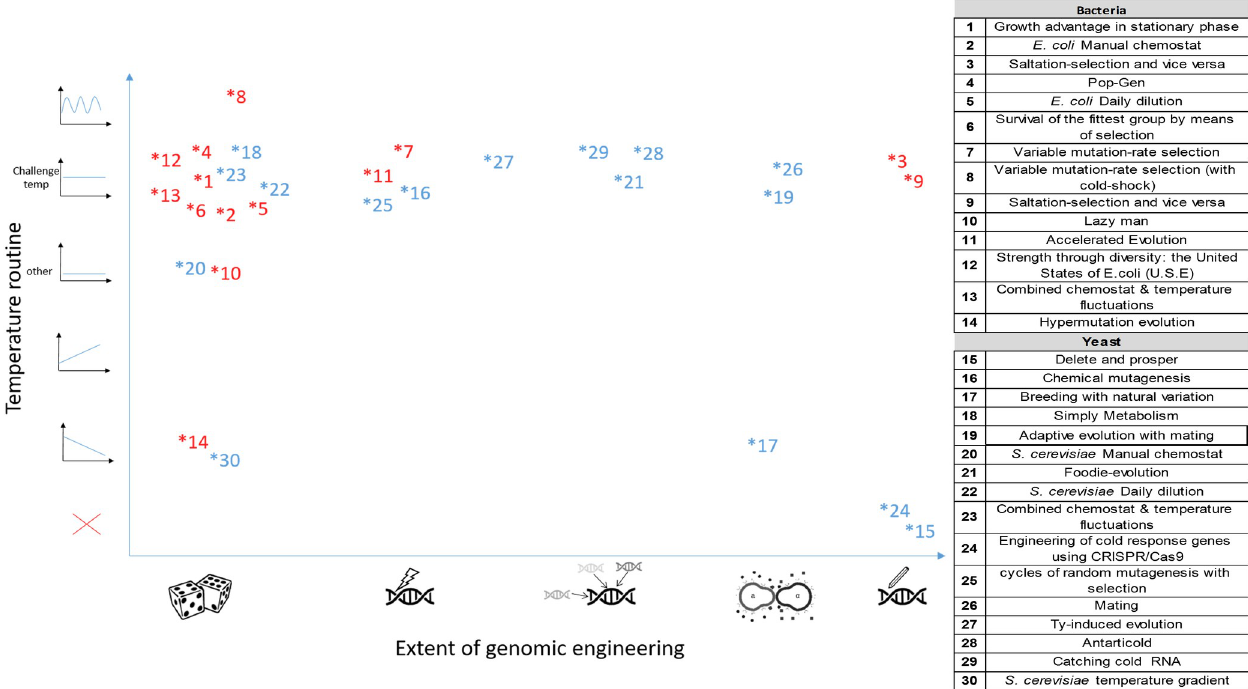
Fig 2. Schematic illustration of the different evolutionary strategies location in the conceptual plan. We conceptually and qualitatively projected all 30 evolutionary strategies onto a plane that is spanned by two principled characteristics of many of the strategies. The x axis denotes the extent of genome engineering and mutagenesis used. The left most strategies used no engineering, the second used mutagenesis, the third used DNA transformation, the fourth used mating (in yeast), and the right most used genome engineering. The y axis denotes the temperature versus evolutionary time regimen experienced by cells during evolution, with strategies exposing cells to fluctuating temperature, constant temperature, monotonically increasing or decreasing temperature, and a strategy (marked by a red X) that involved engineering with no lab evolution. Colors represent organism, E . coli (blue) or S . cerevisiae (red).